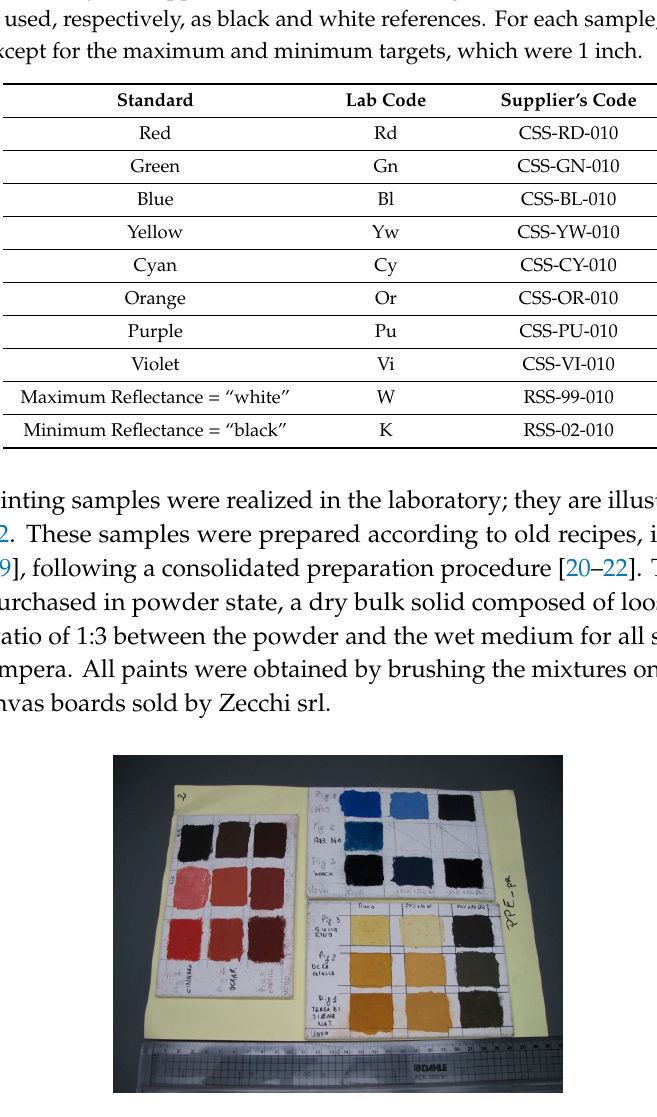
Figure 1. The painting samples realized in the laboratory with pure pigments and egg tempera. Table 2. The pigments listed by hue and the lab code used for the painting sample preparation. Hue